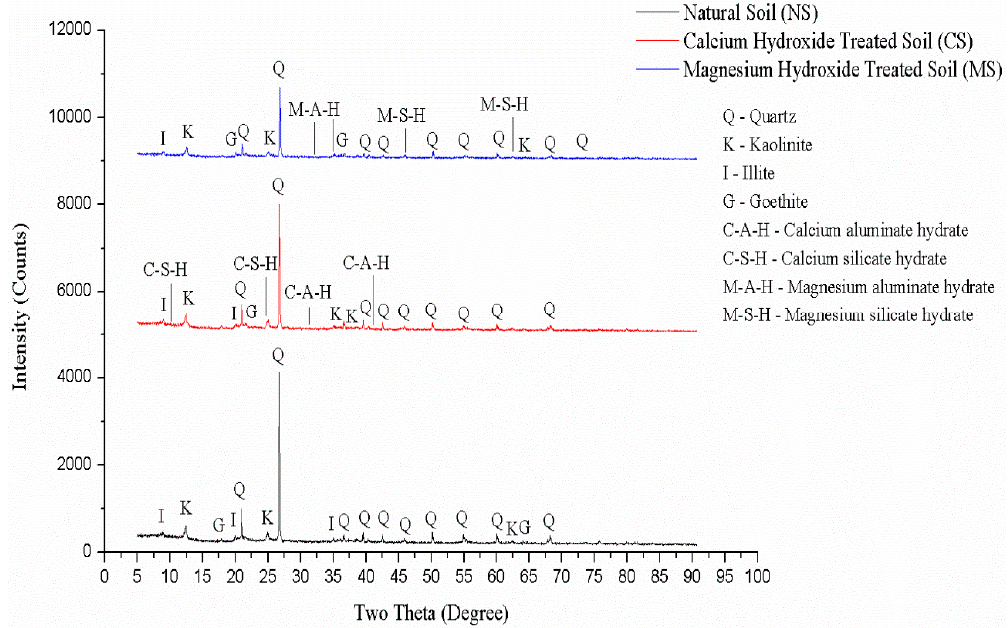
Figure 5. XRD graphs for untreated and nanoparticles-treated residual soils.